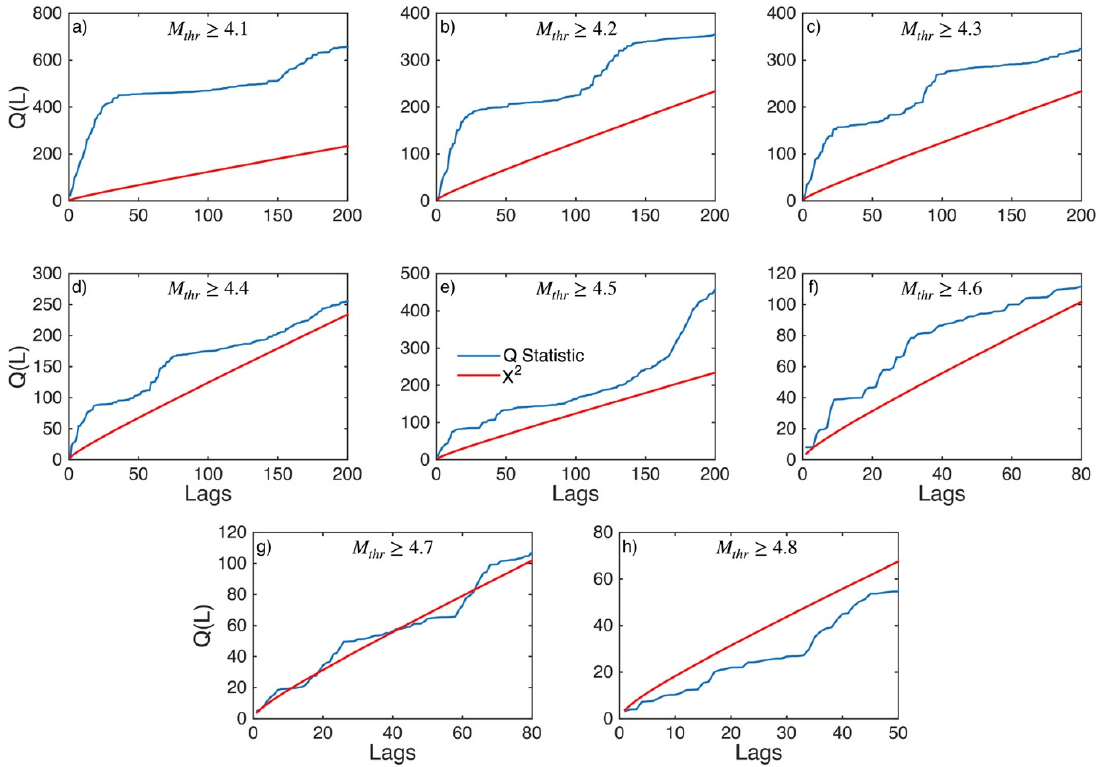
Figure A26. PACF values (orange stems) and their 95% confidence intervals (blue lines) for Northern Greece and Balkans (sub − area 10) for magnitude thresholds ( M thr ) varying from 4.1 to 4.8 (subplots a – h ).